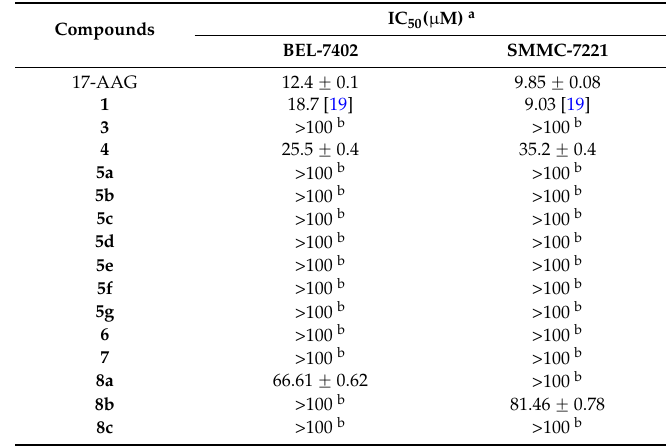
Table 1. In vitro activities of allopurinol derivatives against human hepatoma carcinoma 7402 and 7221 cell